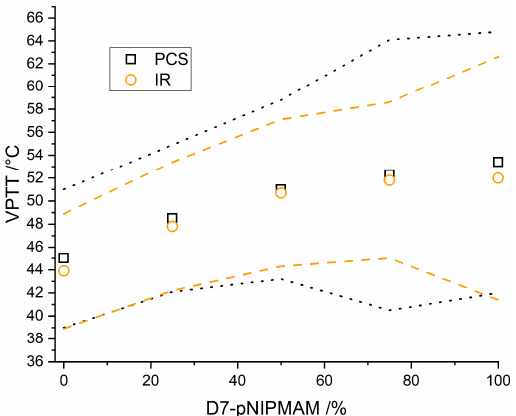
Figure 7. VPTTs (symbols) of D7/H-pNIPMAM co-polymers measured by PCS in water and IR-spectroscopy in heavy water as a function of the D7-NIPMAM content. The broadness of the VPT is indicated via the upper and lower limit of the transition represented with dashed (IR) and dotted (PCS) lines.